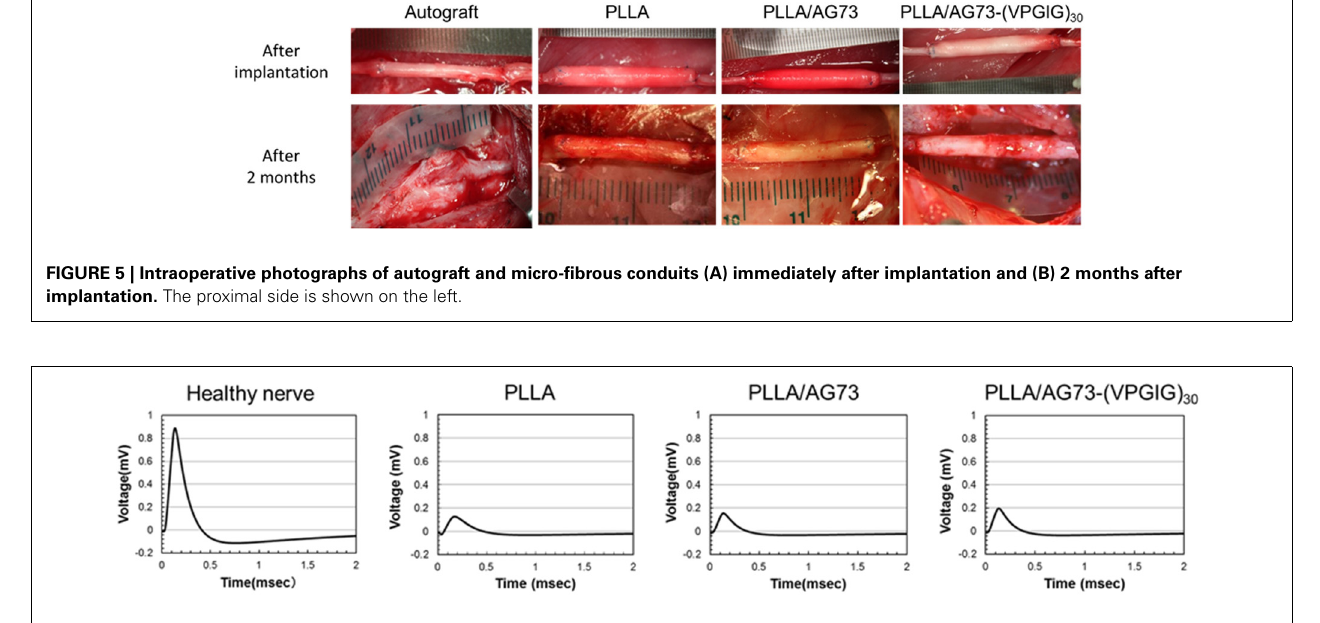
FIGURE 6 | Active potential of healthy nerve and PLLA micro-fibrous conduits 2 months after implantation.